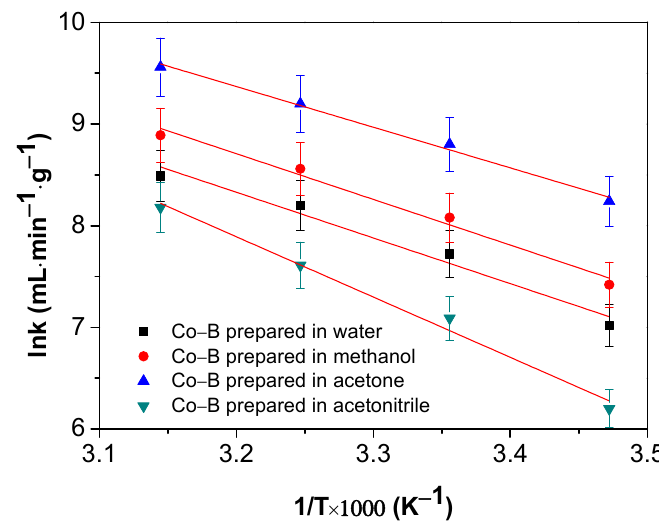
Figure 12. Arrhenius plots of ln k versus 1/ T .